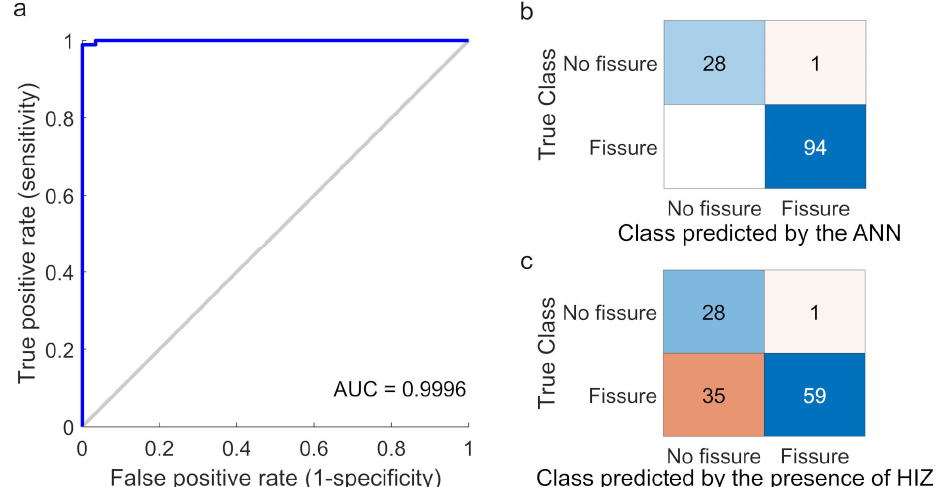
Figure 3. ( a ) Receiver operating characteristic (ROC) by logistic regression. Area under curve